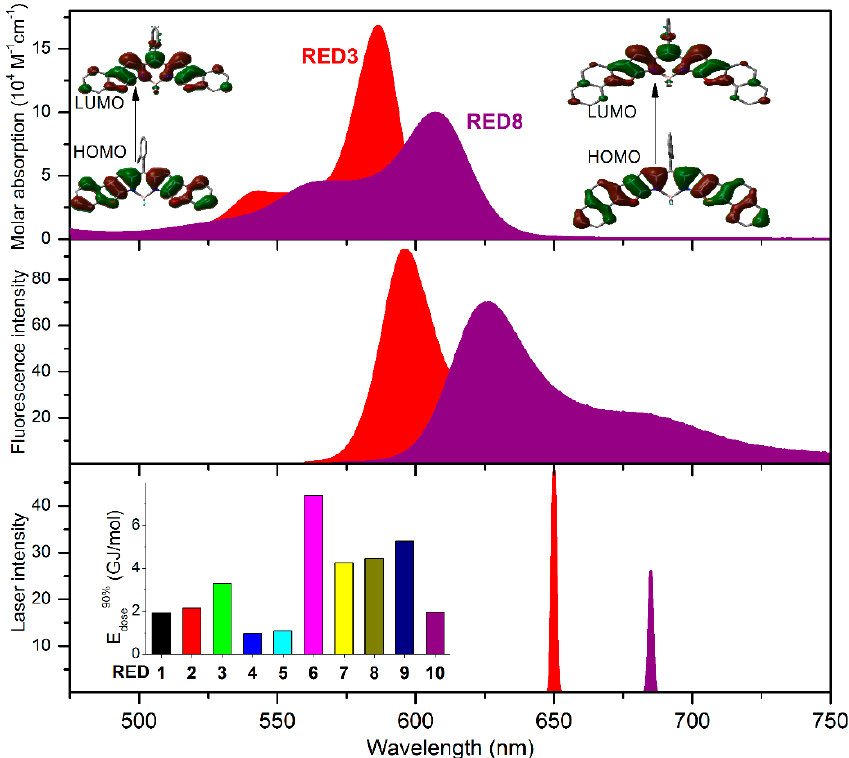
Figure 4. Absorption, fluorescence and laser spectra of representative benzofuran-fused BODIPYs ( RED3 and the more π -extended RED8 ) in ethyl acetate. Inset: top, contour maps (HOMO and LUMO) of the frontier orbitals involved in the electronic transition; bottom, photostability calculated as the energy dose required to decrease 10% of the laser-induced fluorescence (E dose90% ).